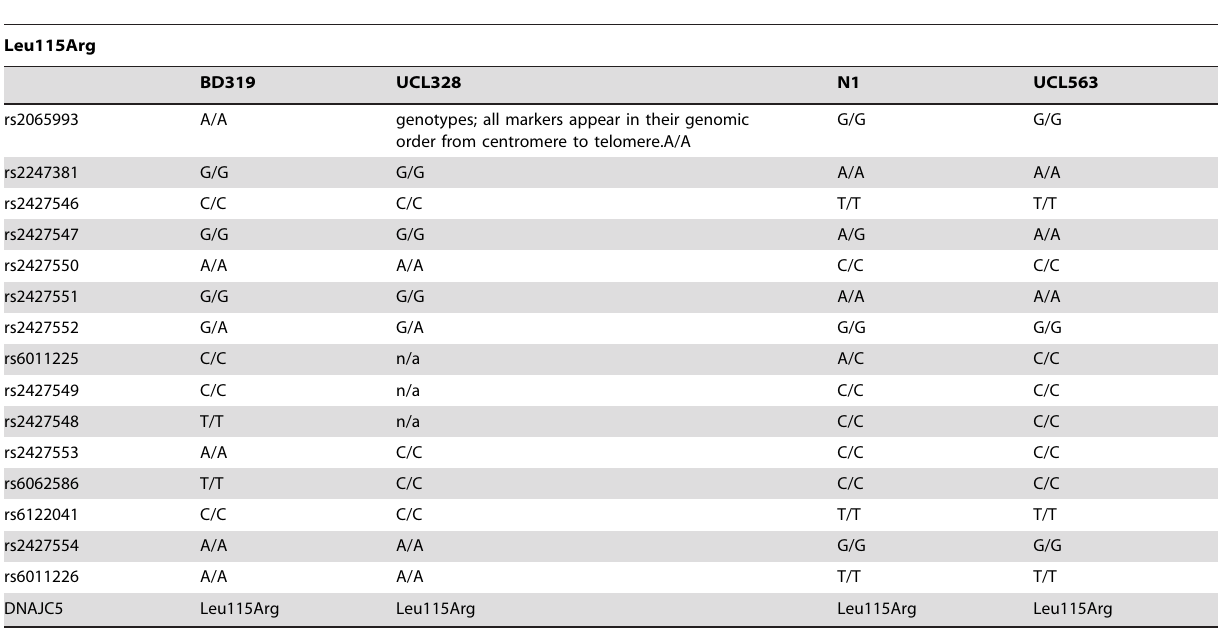
Table 4. Haplotype reconstruction with genetic markers in DNAJC5 .